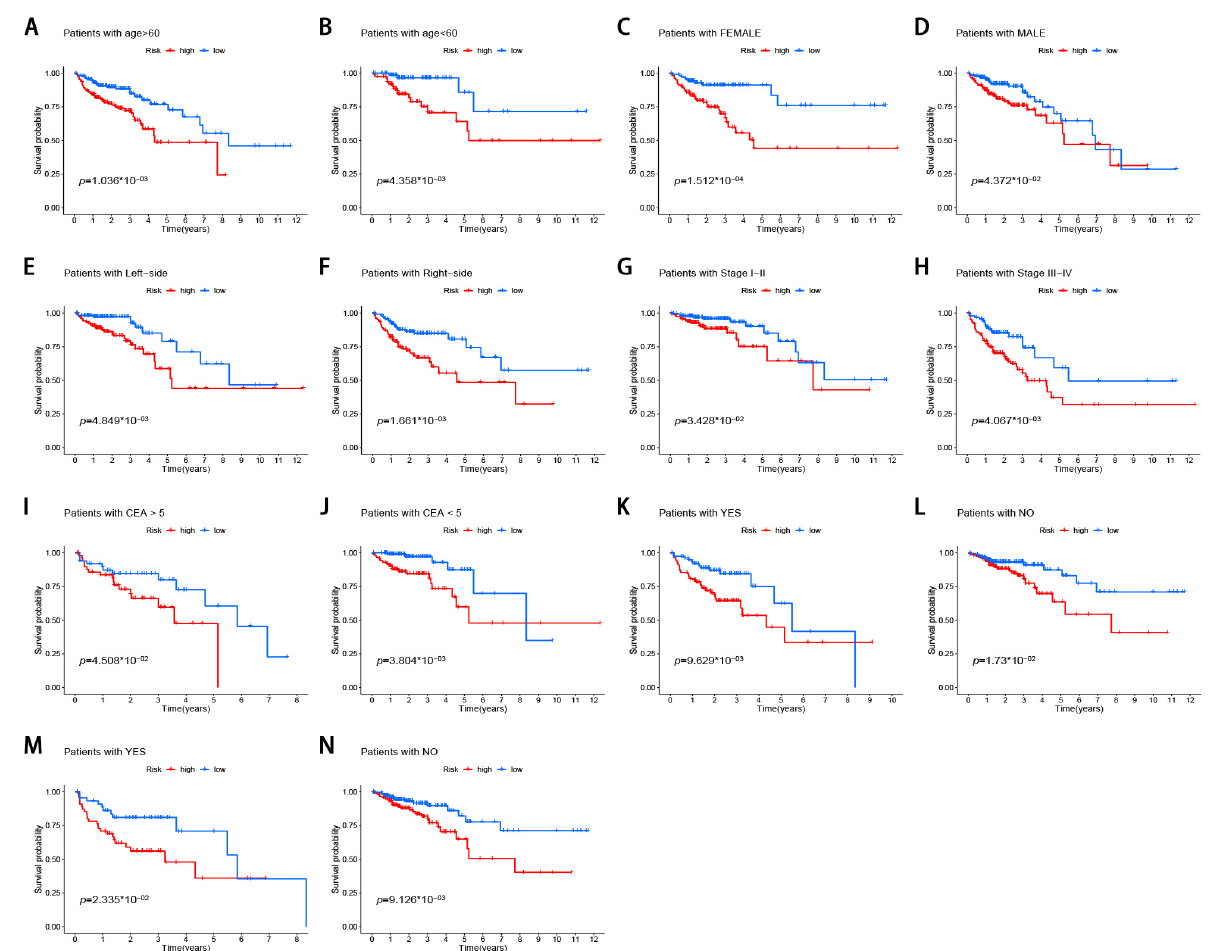
Figure 6. Stratification analysis of the m6A-modified lncRNA signature in CRC. ( A , B ) age (<60 or >60 years old). ( C , D ) gender (female or male). ( E , F ) tumor location (left-side or right-side). ( G , H ) tumor stage (I–II or III–IV). ( I , J ) pretreatment CEA level (<5 or >5). ( K , L ) lymphatic invasion (yes or no). ( M , N ) venous invasion (yes or